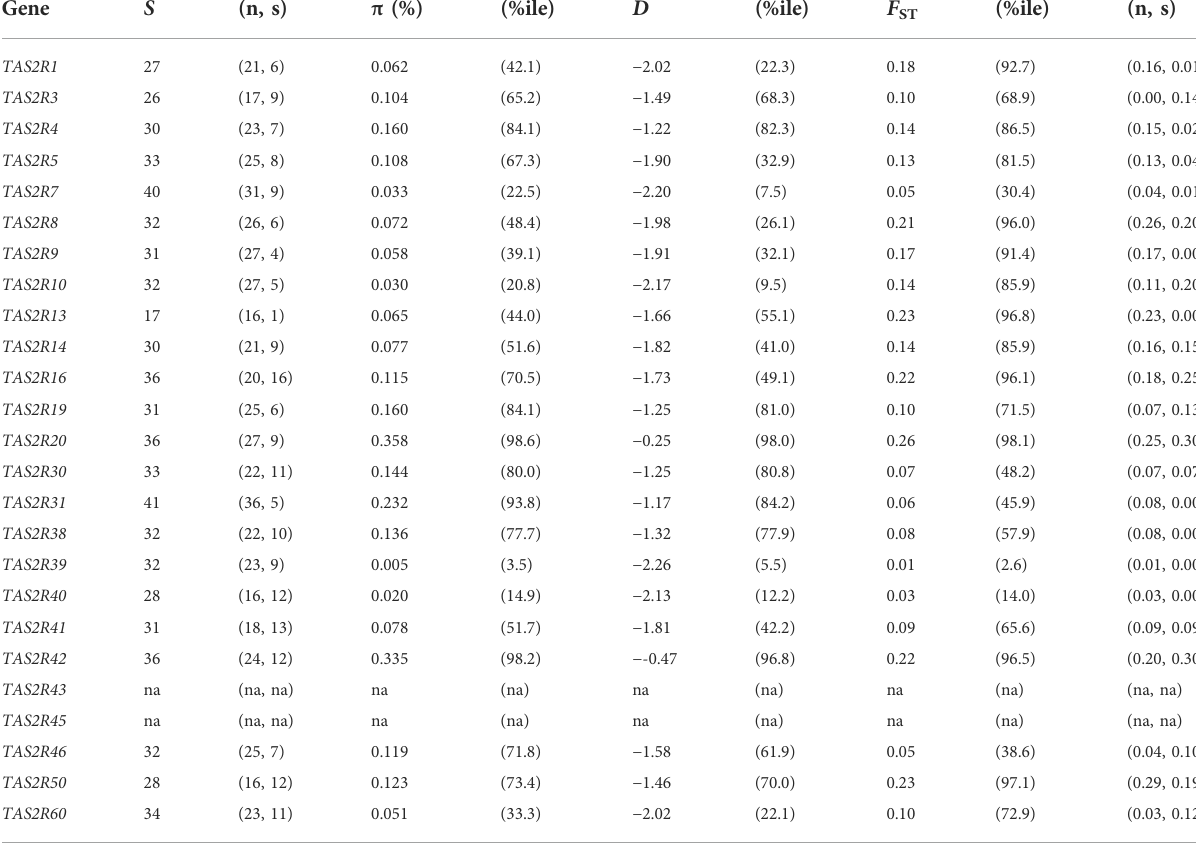
TABLE 3 Summary of variation in TAS2R s. The four main columns are segregating sites ( S ), nucleotide diversity ( π ), Tajima ’ s D statistic ( D ), and population differentiation (